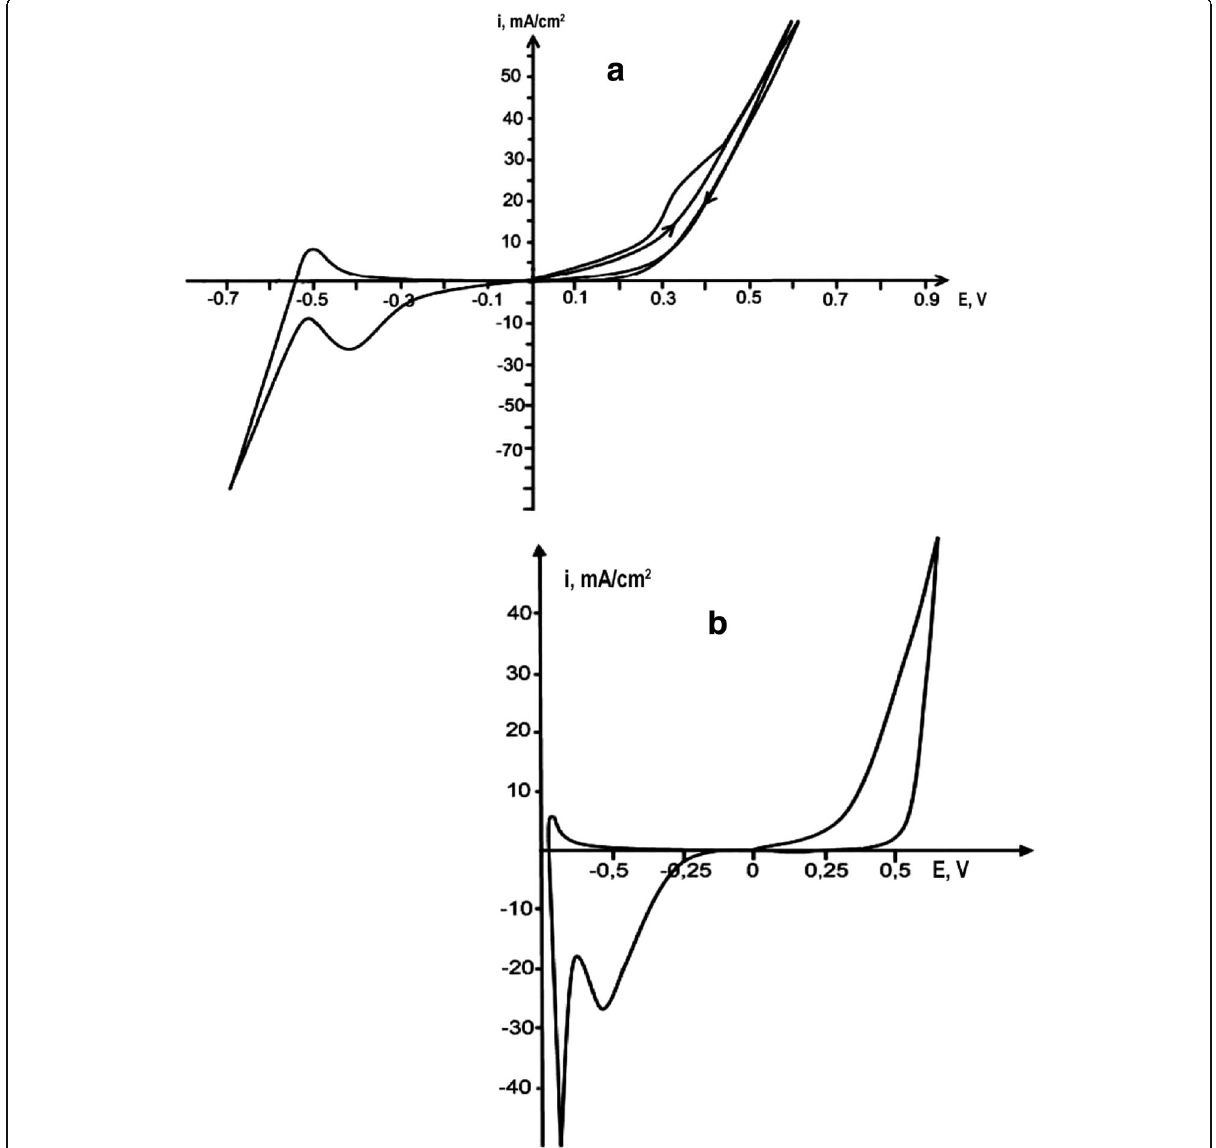
Fig. 1 Cyclic voltammograms of rhodium electrode vs platinum rod in the melt urea-NH 4 Cl ( a ), V p = 0.1 V/s, and acetamide-NH 4 Cl ( b ), Vp = 0.1